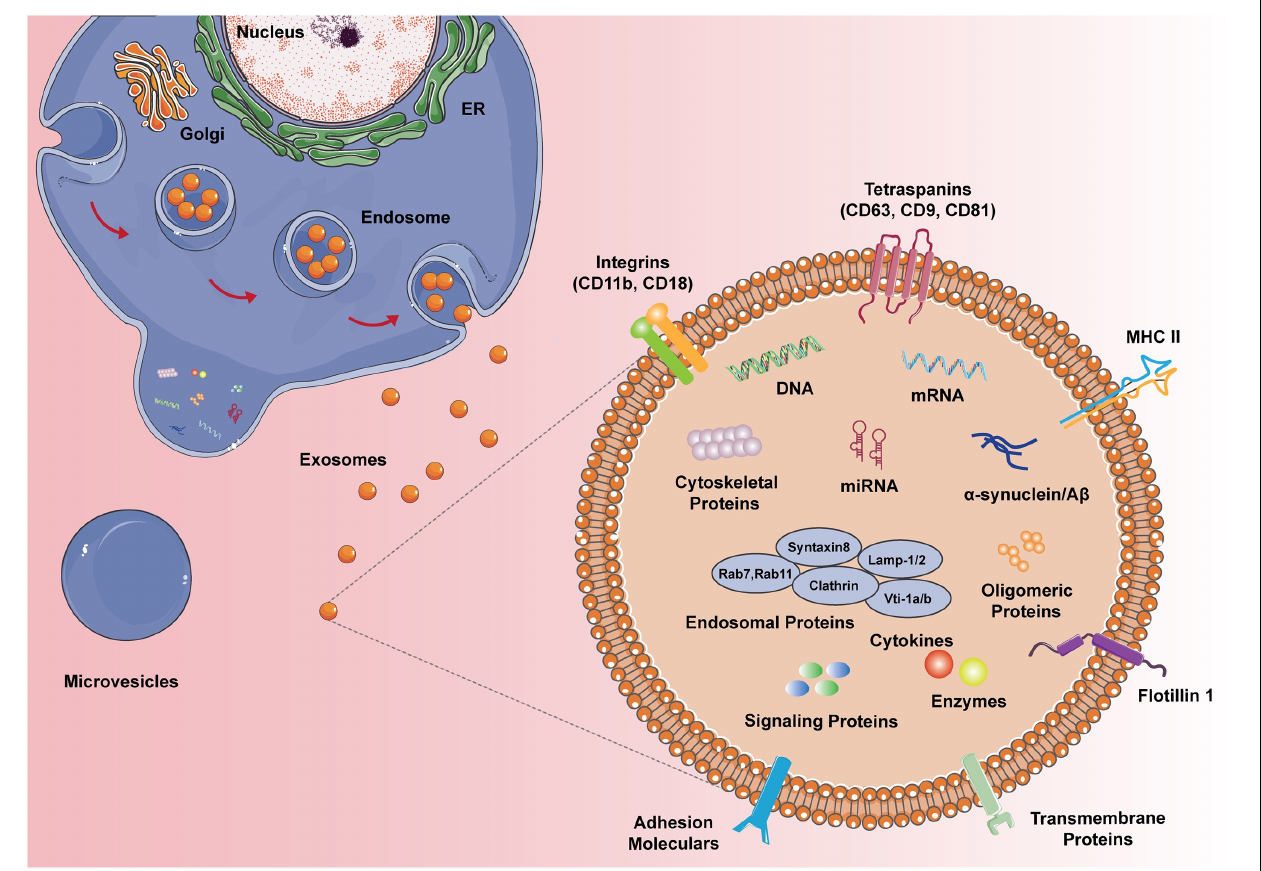
FIGURE 1 | The composition of microglial exosomes. Different from the microvesicles that bus outward from the plasma membrane, exosomes are generated from the endocytic pathway and secretory pathway, hence exosomes carry multiple proteins, DNA, RNA, and lipids from the original cells. Microglial exosomes express endosomal proteins, cytoskeletal proteins, enzymes, and specific MHC II and CD11b. Depending on the status of microglia, exosomes can also have cytokines, signaling proteins, and disease proteins like α -syn and A β